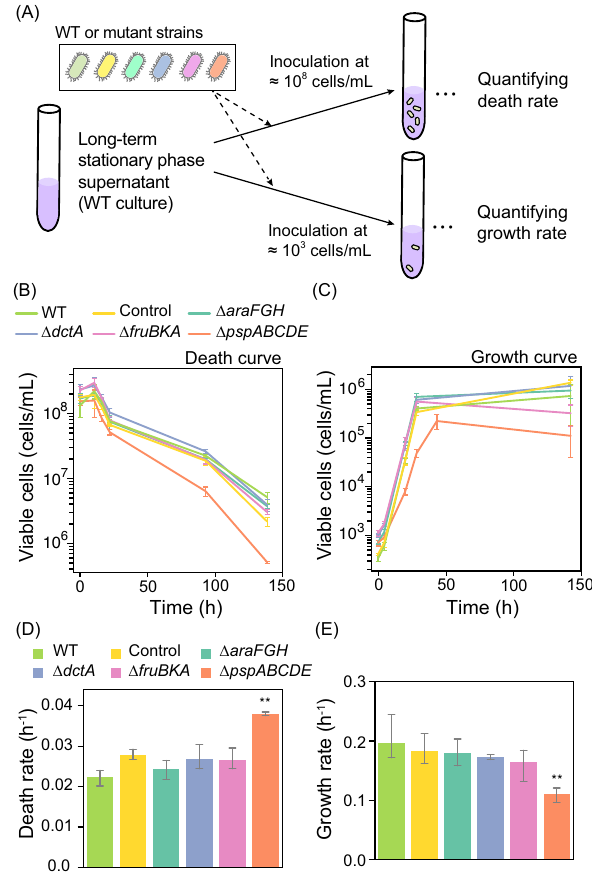
Figure 4. The effect of the deletions of highly expressed genes in LTSsn on survival and growth in the long- term stationary phase supernatant. ( A ) Experimental design for measuring death and growth rate of mutant strains in the long-term stationary phase supernatant. We prepared the supernatant from the WT cell cultures, and inoculated cells of mutant or WT strains. ( B , C ) Temporal changes in the number of viable cells in the MDS42 or its mutant strains inoculated into the LSP supernatant at 10 8 or 10 3 cells/mL. The number of viable cells was estimated by the CFUs. Error bars indicate standard deviations of biological triplicates. ( D , E ) Death and growth rate of knock-out mutants in the long-term stationary phase supernatant. From the population growth or decay curves in panels A and B, we estimated the growth and death rates in each strain. Error bars indicate the standard deviation of biological replicates (n = 3). We performed Dunnett’s test between each of the knock-out mutants ( ∆araFGH, ∆dctA, ∆fruBKA, or ∆pspABCDE ) and a “Control” strain (see “Methods”) (**, p <